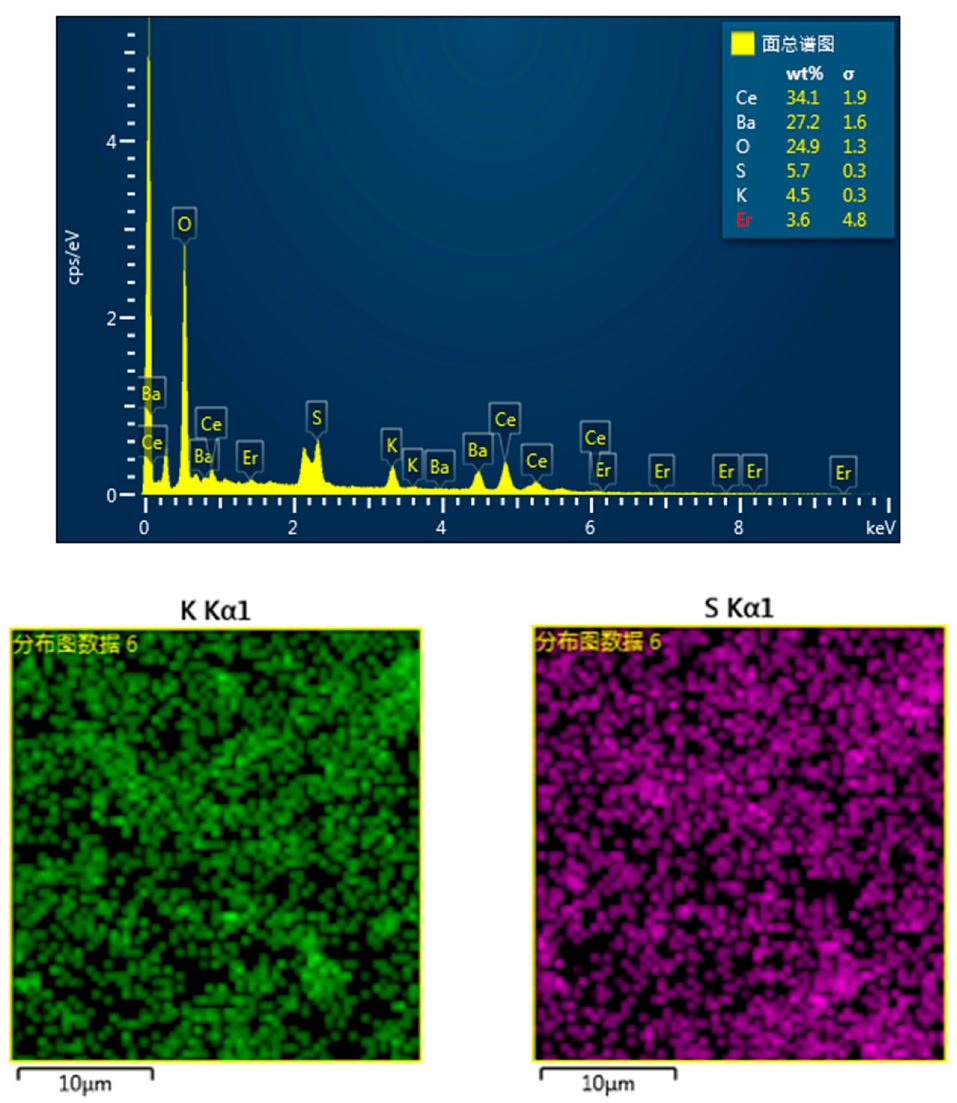
Figure 3. The energy-dispersive X-ray spectroscopy and elements mapping images in BaCe 0.9 Er 0.1 O 3 − α –K 2 SO 4 –BaSO 4 .